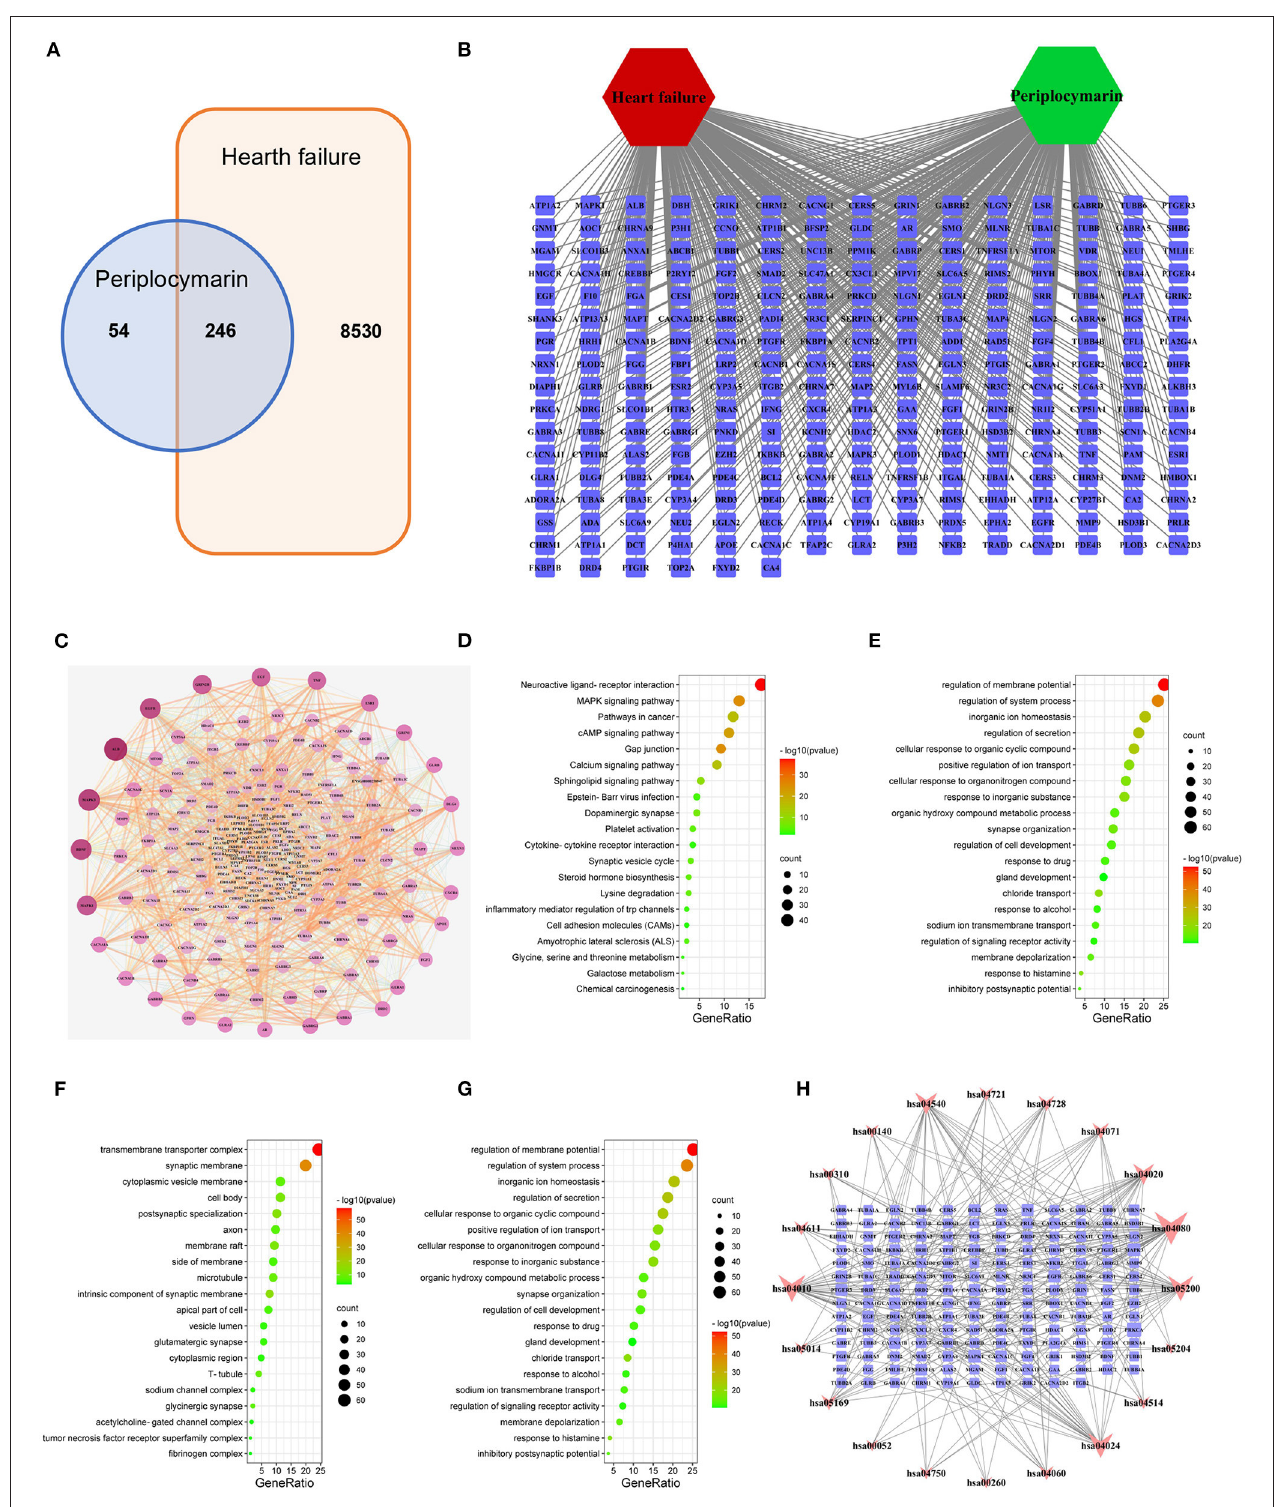
FIGURE 5 | Network pharmacology to explore the mechanism of periplocymarin in the treatment of heart failure. (A) Intersection targets of periplocymarin and heart failure. Periplocymarin:300 targets; heart failure:8,770 targets. (B) The network of heart failure-targets-periplocymarin. Green hexagon represent compound,